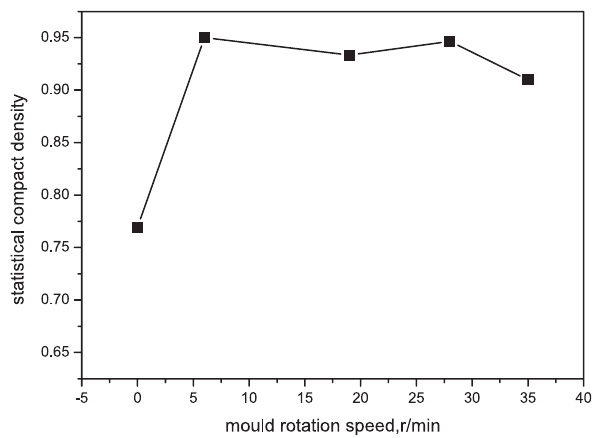
Fig. 8: Relation between the statistical compact density and mould rotation rate.